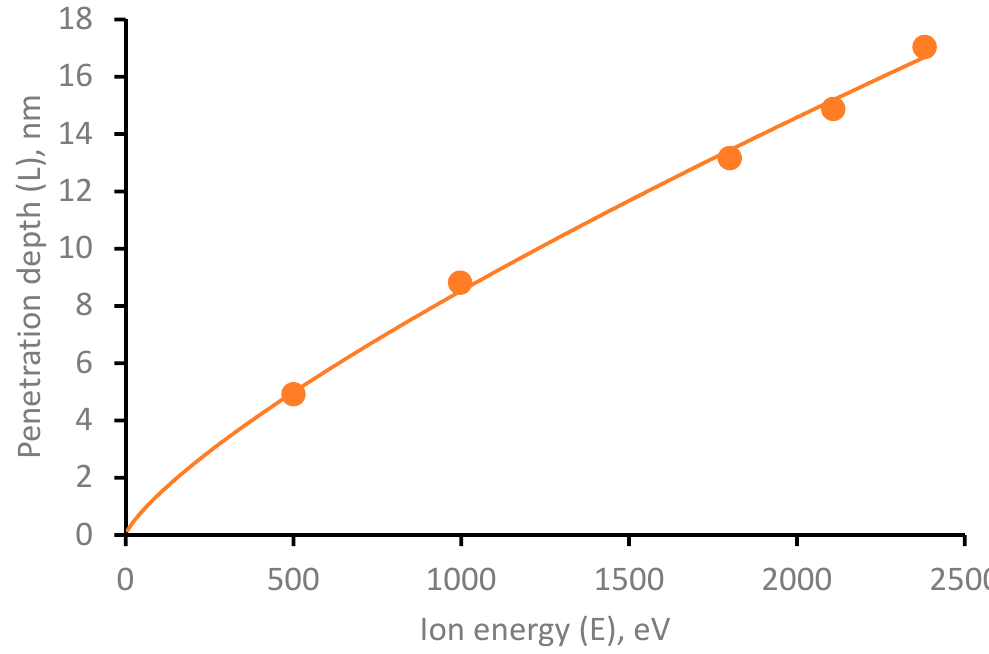
Figure 3. Dependence of the penetration depth of Cu atom into PCL depending on its initial energy. In the energy range under consideration, a power-law dependence of the penetration depth on the atom’s energy is obtained, described by the equation L=4.07 · 10 − 2 · E 0.7739 . It is worth noting that in the process of penetration into the PCL, the copper atom has